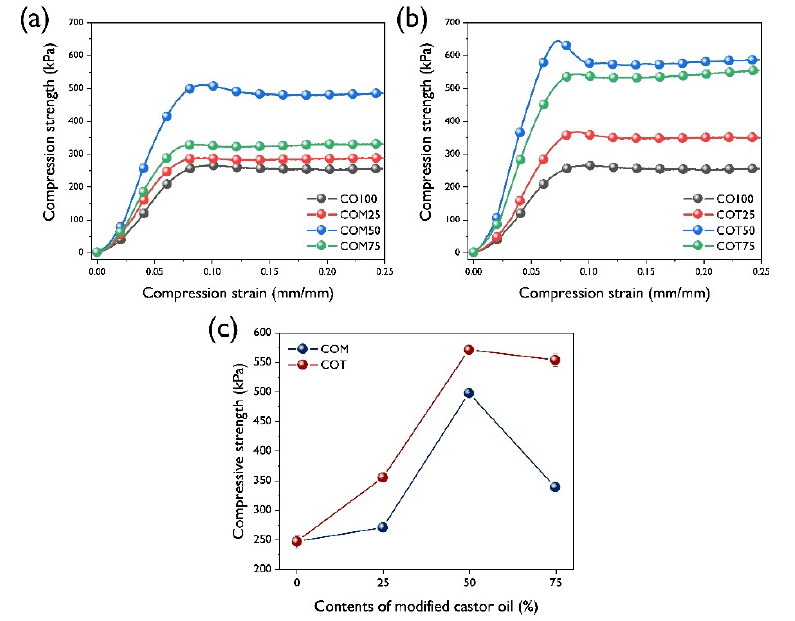
Figure 6. Compressive stress–strain curves of the PU foams prepared from ( a ) COM and ( b ) COT. ( c ) Compressive yield stress of the PU foams made from COM and